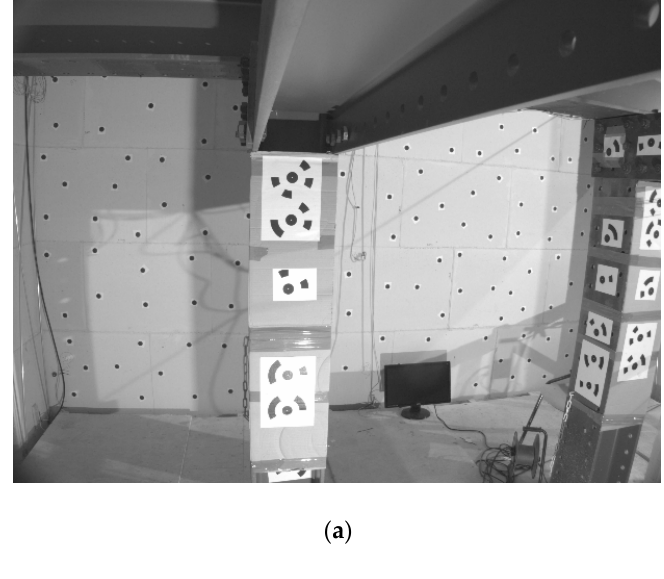
(Table 2). In addition, several invariants (target diameter) were used to scale the photogrammetric model (Figure 8). As a result, it was possible to estimate the spatial position of each camera with a re-projection root-mean-square error (RMSE) error of 0.16 pixels and a relative error in terms of invariants (re-projected diameters) of 1.53% (Table 3). Regarding the checkpoints, the re-projection error obtained had a sub-pixel accuracy of 0.30 pixels (0.52 mm) with a maximum value of 0.50 pixels for those checkpoints placed at positions 3, 5, and 6 (Table 3).